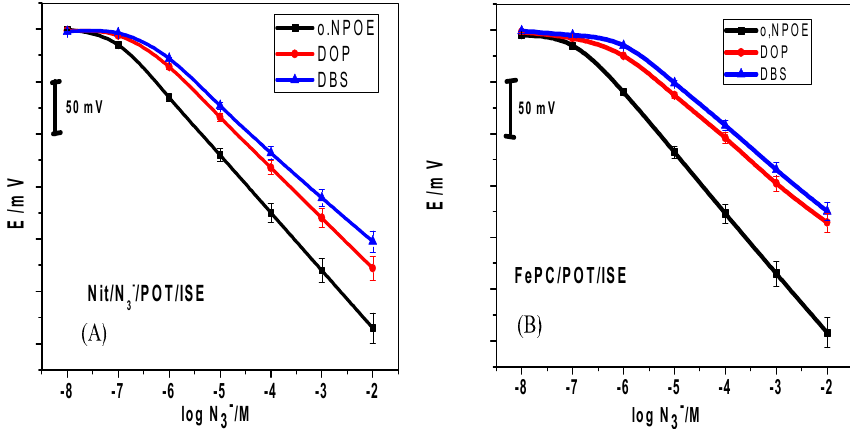
Figure 2. Effect of plasticizer polarity on the potentiometric plot of ( A ) Nit/N 3 − /POT-ISE and ( B ) FePC/POT-ISE. Background: 10 − 2 M Tris buffer solution, pH 7.0.